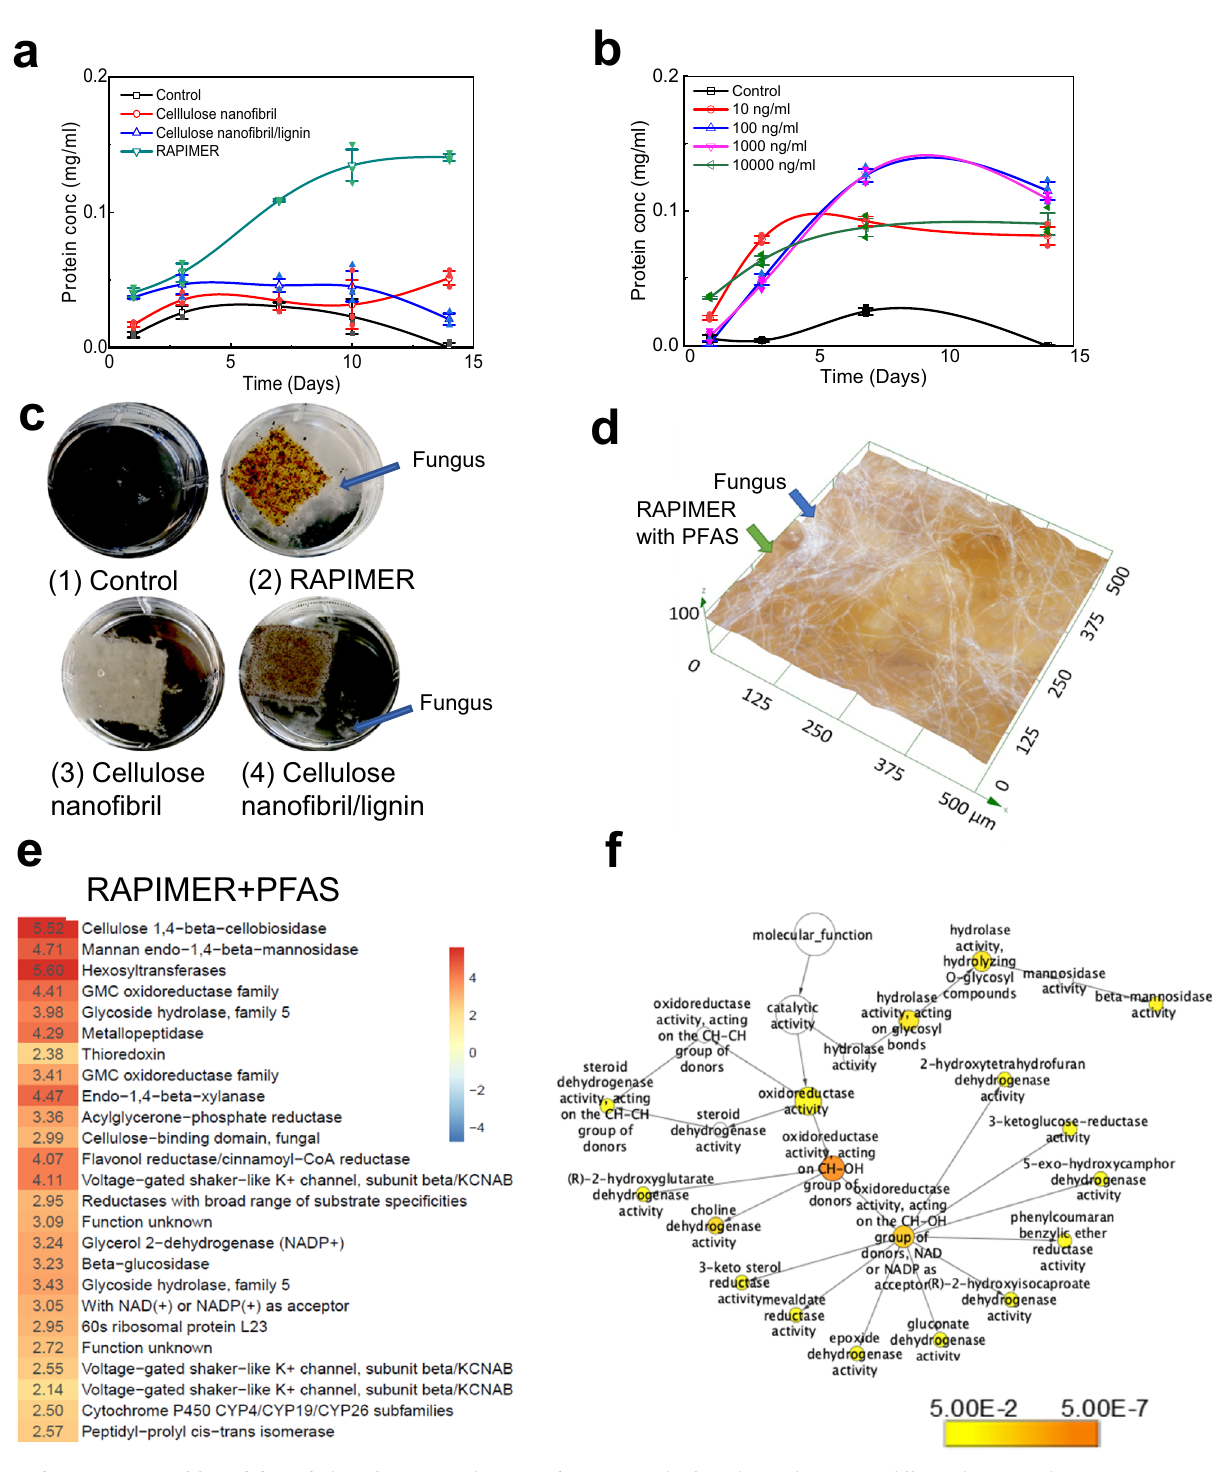
Fig. 5 The assessment of fungal degradation of RAPIMER integrated system. a The fungal growth curve on different bioinspired composites. Top green line: RAPIMER composite, blue line: cellulose nano fi bril/lignin composite, red line: cellulose nano fi bril, black line: glucose deprived Kirk media as the control. b The fungal growth curve on RAPIMER composite treated with solutions in different PFAS concentrations. The blue line: 100 µ g/L. The purple line: 1000 µ g/L. The green line: 10,000 µ g/L. The red line: 10 µ g/L. The black line: Kirk media as the control. All PFAS solution is the mixture of PFOA/PFOS (1:1). For a and b, the experiment was reproduced n = 3 times. The mean with error bar represents the average value and standard deviation (SD) of experimental replicates. c The microscope images of fungal growth on different materials. (1) Glucose-derived Kirk media, (2) RAPIMER composite, (3) Cellulose nano fi bril composite, (4) cellulose nano fi bril/lignin composite. The background is adjusted into black to show the fungus mycelia. d The digital microscopy image of I. lacteus hyphae growing on the RAPIMER substrate adsorbed with PFAS. e The RAPIMER-induced overexpressed enzymes upon PFAS treatment. The numbers denoted the normalized spectra counts for the proteins in the heat map. f The GO enriched pathway analysis of upregulated proteins in the PFAS treatment